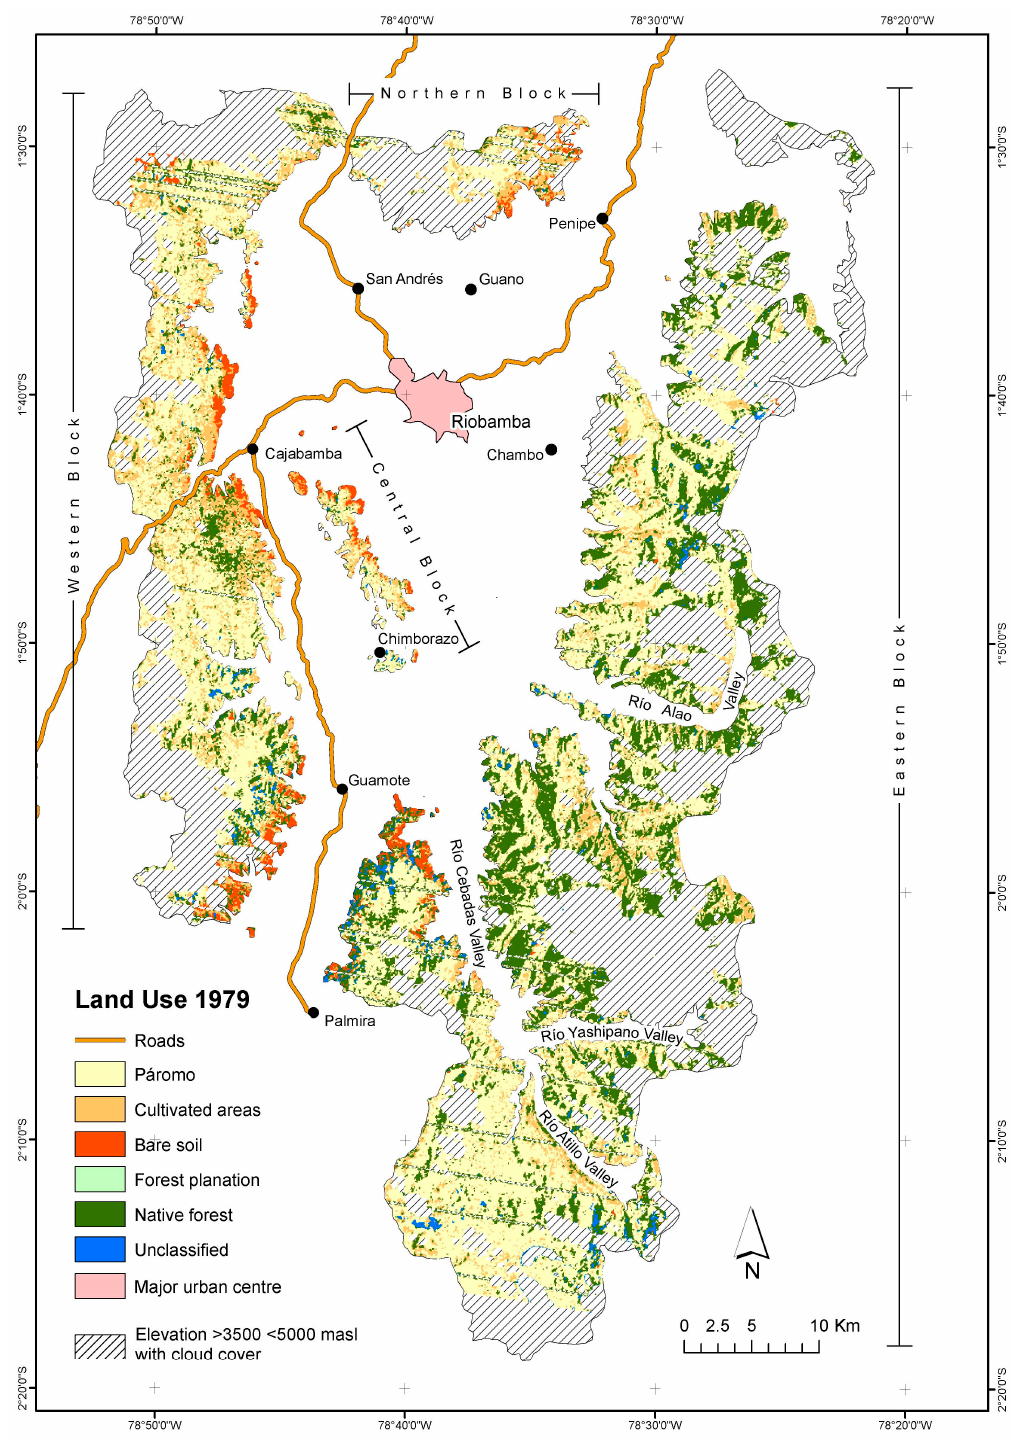
Figure 2. Chambo Basin: land-use, 1979.